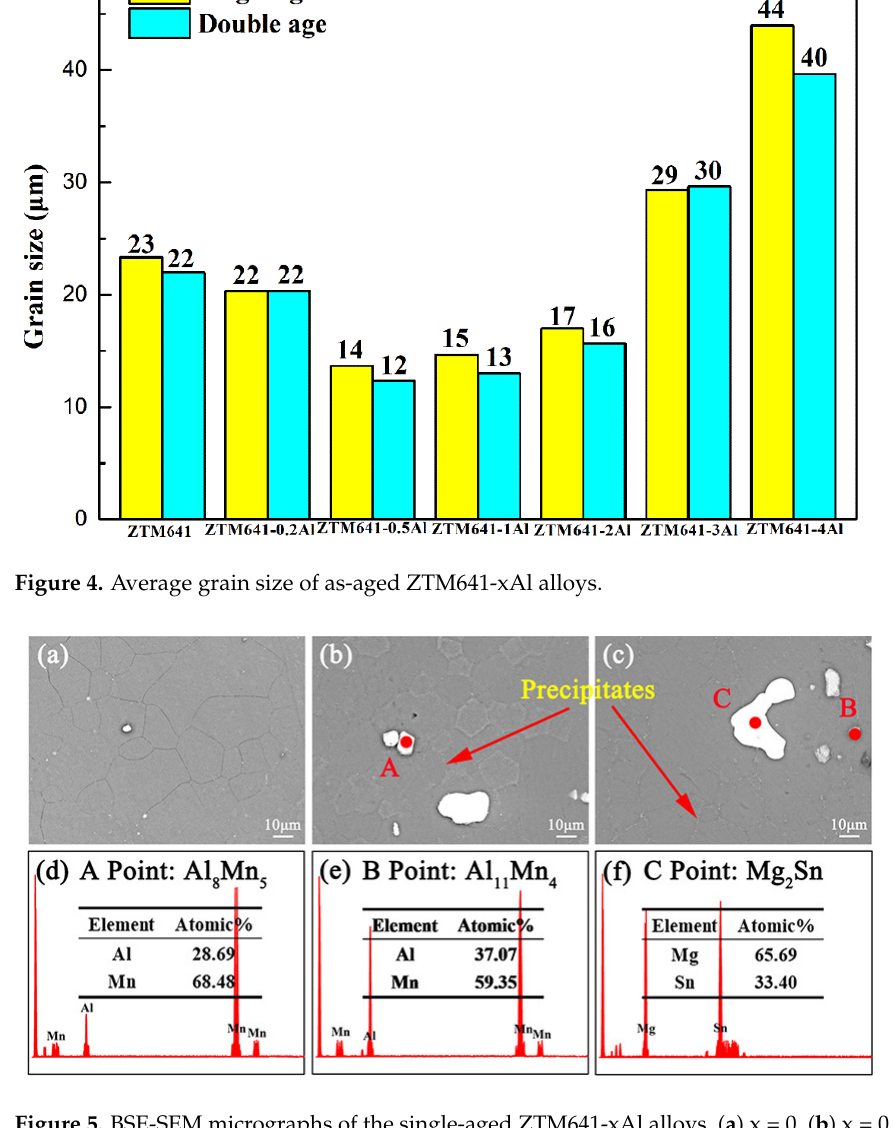
Figure 4. Average grain size of as-aged ZTM641-xAl alloys.